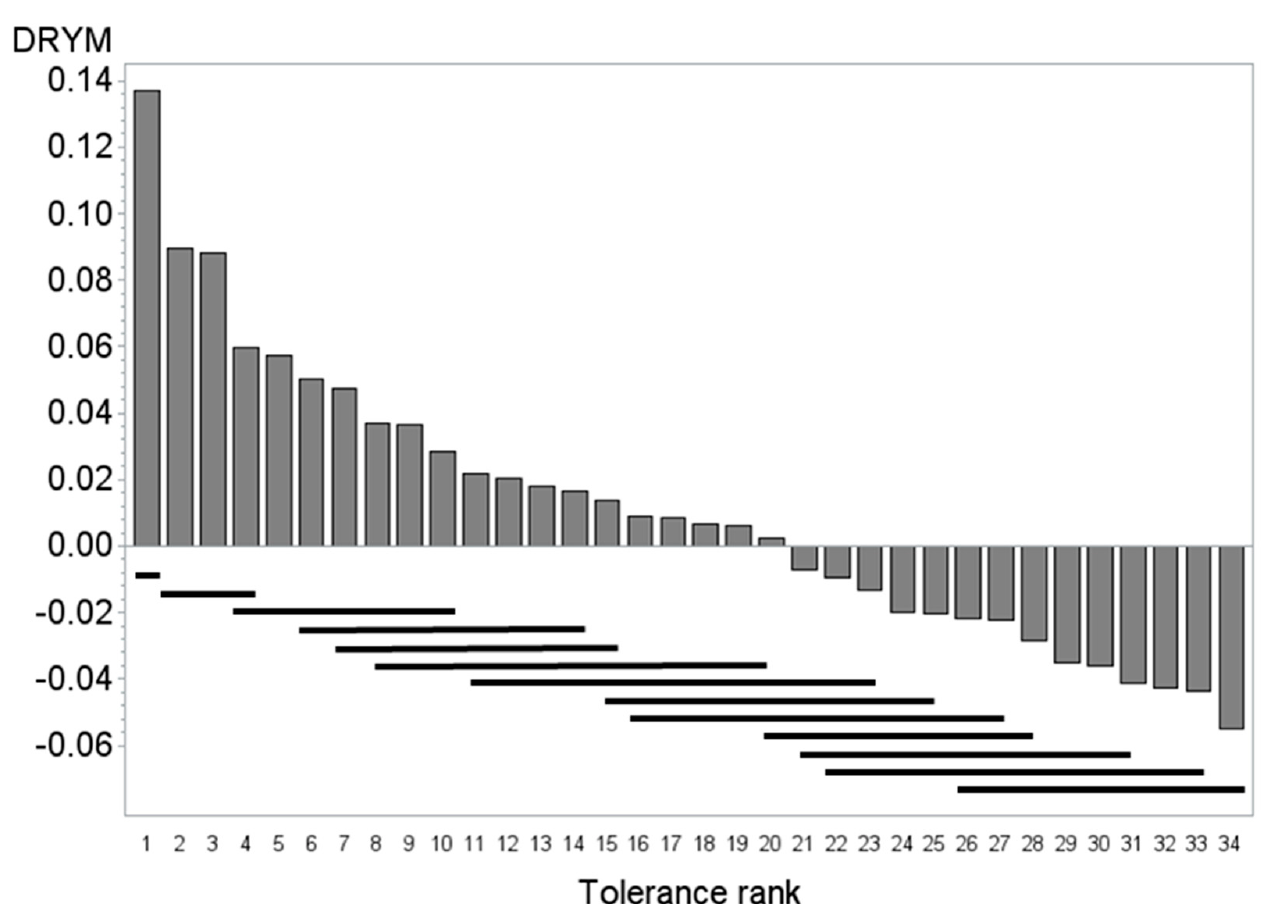
Figure 4. Ranking of the 34 potato varieties of the association panel according to the drought tolerance. Drought tolerance index (DRYM) of 34 potato varieties against rank of cultivar according to drought tolerance (DRYM) (1 most drought tolerant, 34 most sensitive). The bars at the bottom of the figure indicate the grouping according to the means comparison (REGWQ, α = 0.1). Cultivars that are underlined by the same bar are not significantly different in DRYM, e.g., 1 (most tolerant group) is different from 2 to 4 that belong into the second most tolerant group.